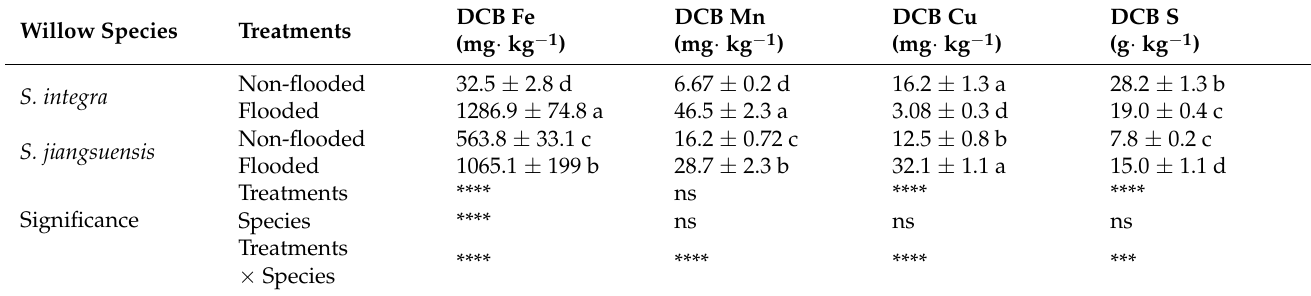
Table 3. Fe, Mn, Cu, and S concentration (DW) in the plaque on the root surfaces of S. integra and S. jiangsuensis exposed to Cu-contaminated soil under non-flooded/flooding conditions for 90 d.